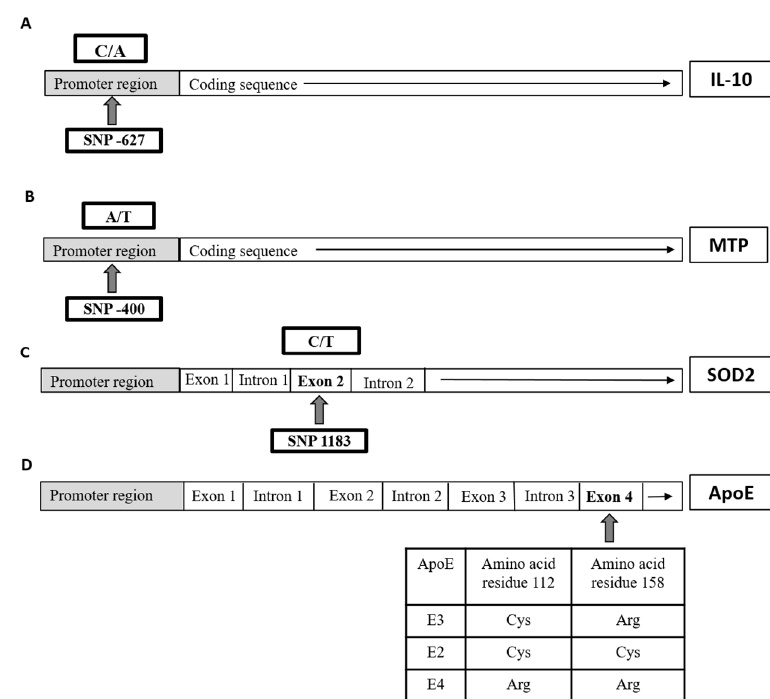
Figure 1. Schematic illustration of each single nucleotide polymorphisms (SNP) location on the gene level of ( A ) interleukin 10 ( IL10 ), ( B ) microsomal triglyceride-transfer protein ( MTP ), ( C ) superoxide dismutase-2 ( SOD2 ), and ( D ) apolipoprotein E ( APOE ) in the studied groups. Table 1. Primer sequences, enzymes used, and digested products obtained for detection of IL-10 , MTP , SOD2 , and APOE gene polymorphisms by polymerase chain reaction-restriction fragment length polymorphism (PCR-RFLP).